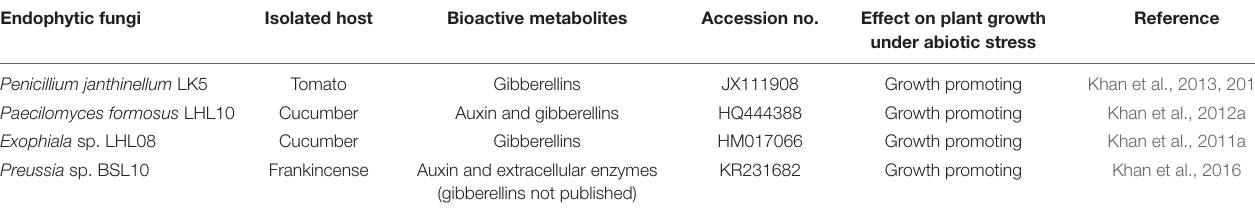
TABLE 1 | List of endophytic fungi with their traits used for initial screening of assessing their metal metals tolerance. Endophytic